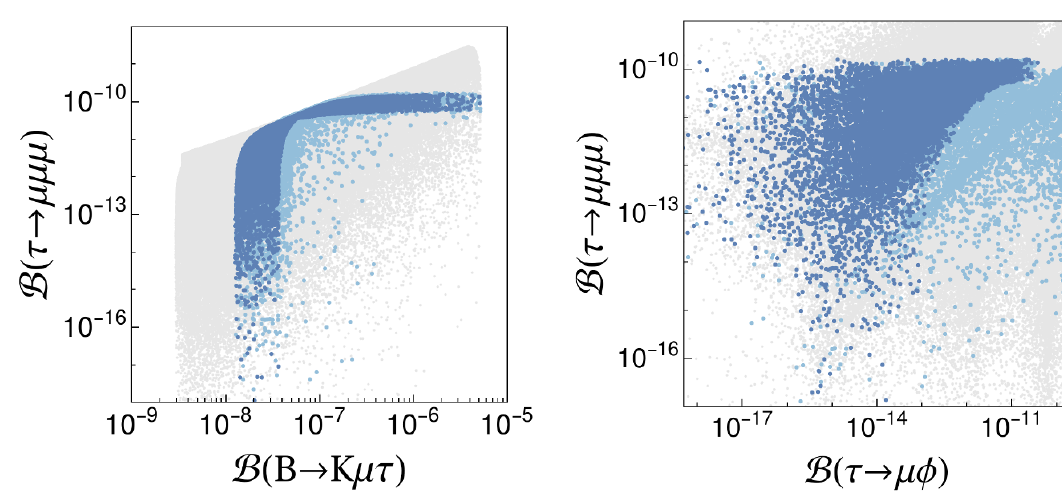
Figure 5 . Left panel: correlation between B ( B ! K(cid:28) (cid:6) (cid:22) (cid:7) ) and (cid:28) ! 3 (cid:22) . Right panel: correlation between (cid:28) ! 3 (cid:22) and (cid:28) ! (cid:22)(cid:30) . Color code as in (cid:12)gure